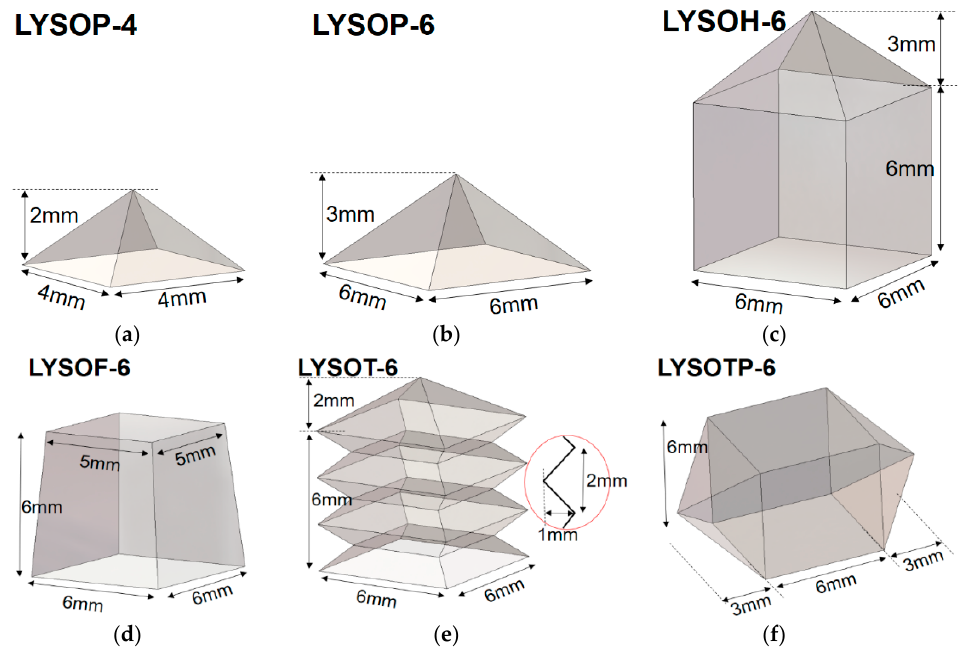
Figure 4. Shape and size of the odd-shaped scintillator configurations. ( a ) LYSOP-4 crystal, ( b ) LYSOP-6 crystal, ( c ) LYSOH-6 crystal, ( d ) LYSOF-6 crystal, ( e ) LYSOT-6 crystal and ( f ) LYSOTP-6 crystal.